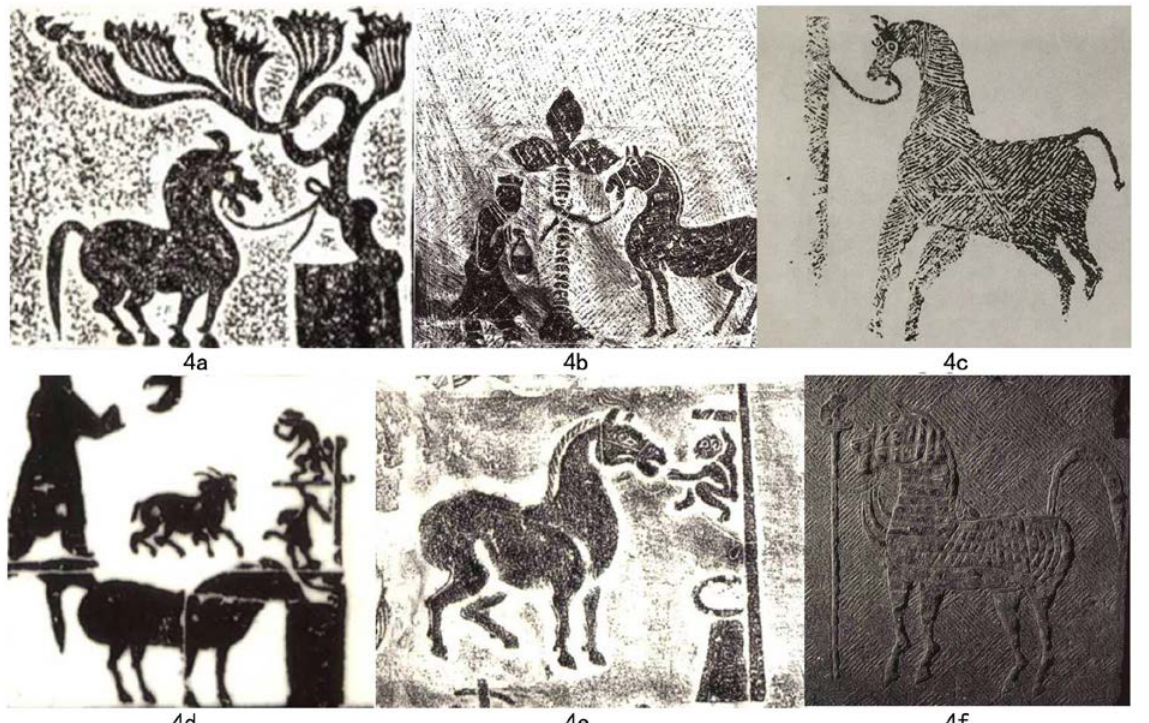
Figure 4. Trees and wood posts: a) Rubbing of Han tomb stone, Suide Han tomb, Shaanxi province (Editorial Committee of the complete works of Chinese portrait stone 2000); b) Rubbing of tomb stone, Xingjing Han stone coffin, Sichuan province (Editorial Committee of the complete works of Chinese portrait stone 2000); c) Rubbing of tomb stone, Hongmiaoziya Han stone coffin, Sichuan province (Gao 2011); d) Rubbing of tomb brick, Mixian Dahuting Han tomb, Henan (Editorial Committee of the complete works of Chinese portrait stone 2000); e) Rubbing of tomb brick, Zengjiabao Han tomb, Sichuan province (Chen 1981); f) Rubbing of Xinjin NO.3 stone coffin, Sichuan province (Editorial Committee of the complete works of Chinese portrait stone 2000).